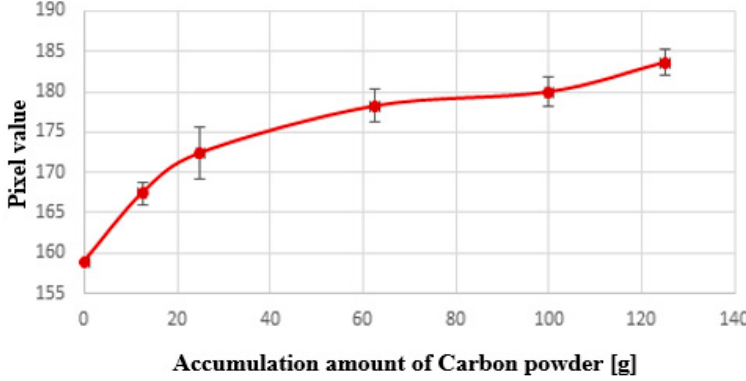
Figure 8. The graph of pixel values according to carbon powder accumulation condition. Table 6. Pixel values according to each accumulation condition (carbon powder).